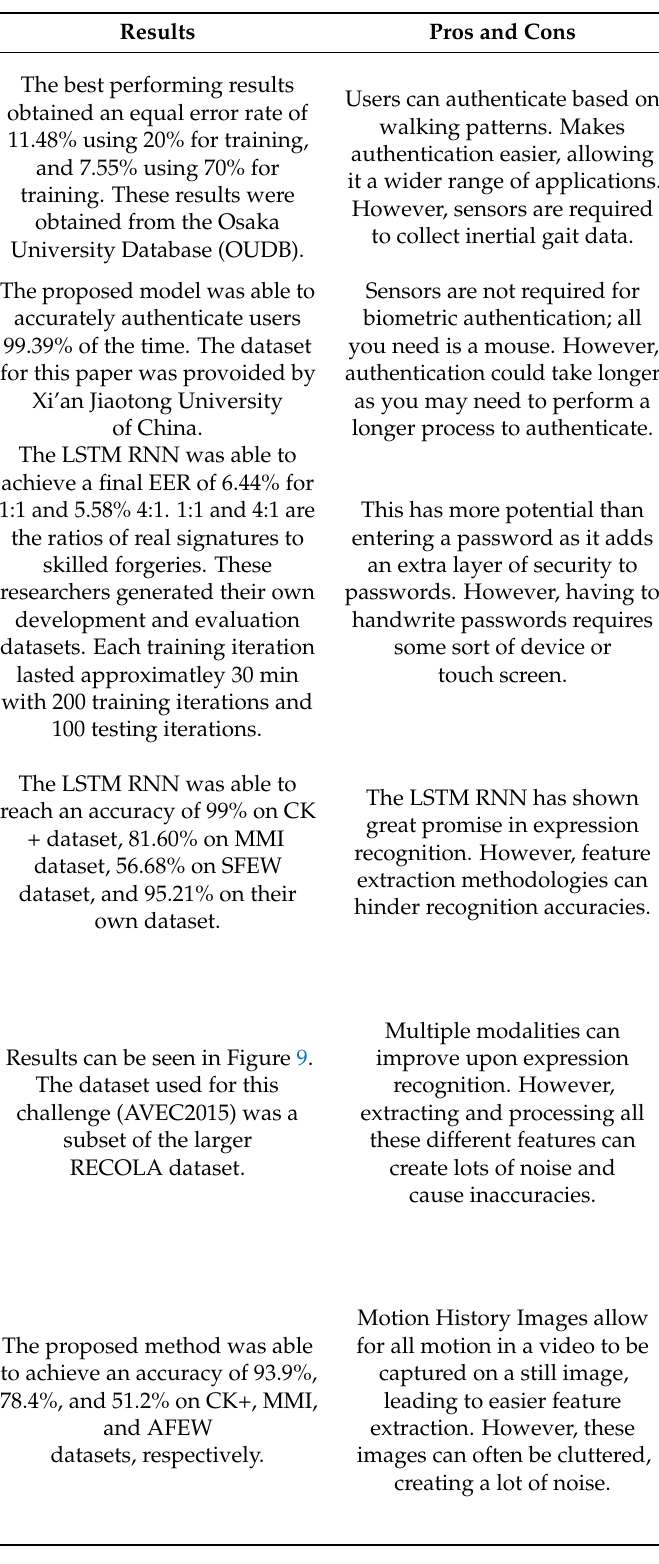
Table 1. Comparison of existing RNN